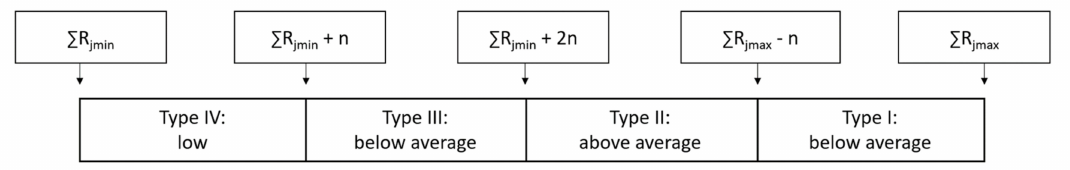
Figure 1. Scale to classify T j territories on the degree of agricultural land activity. Source: Authors’